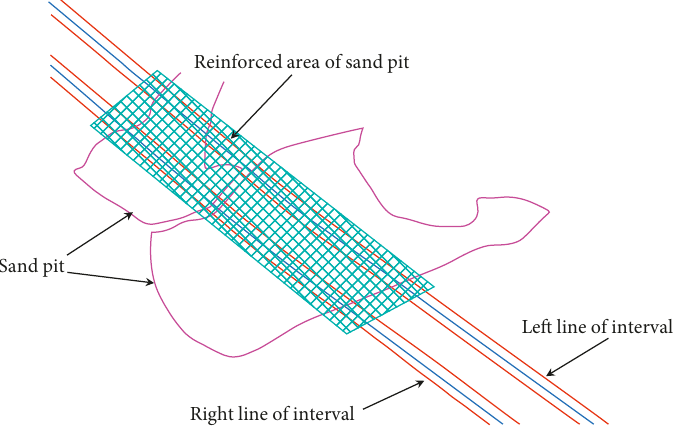
Figure 13: Diagram of the reinforced